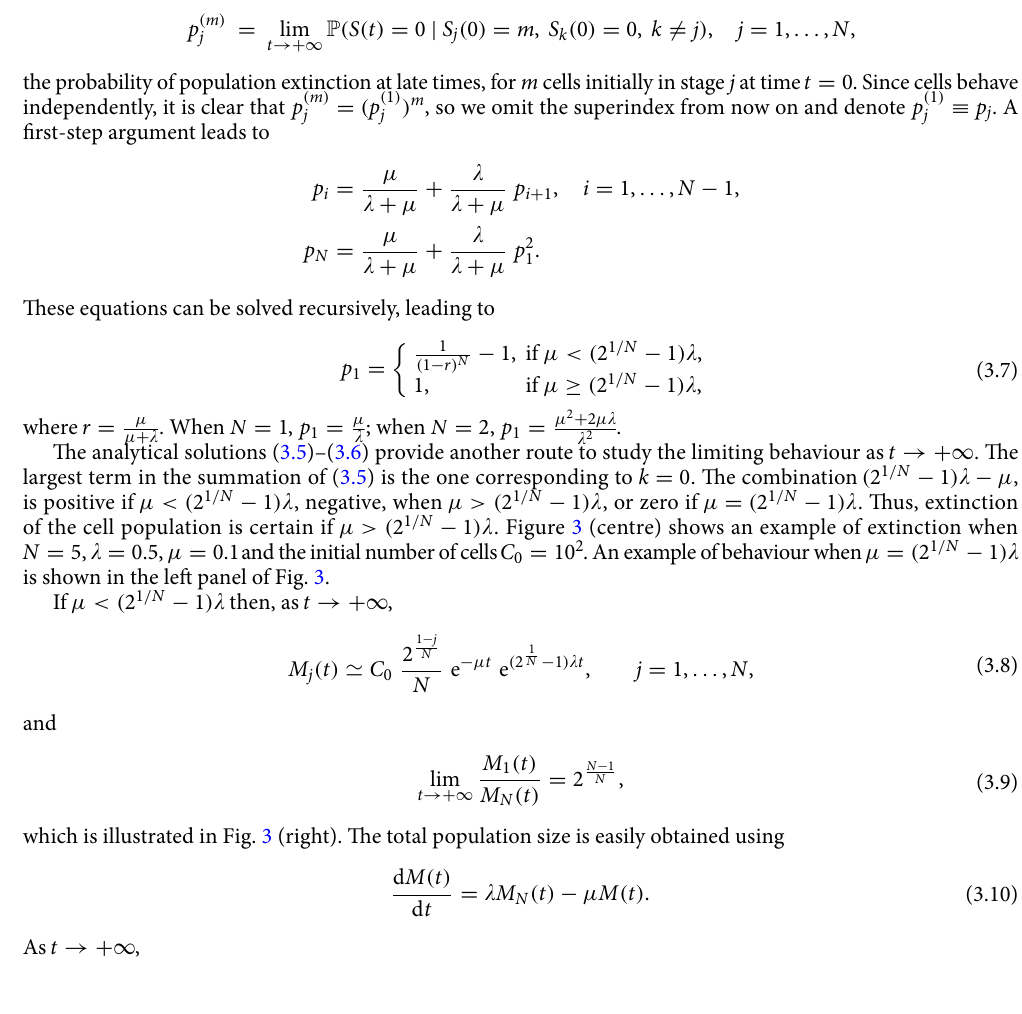
of a population with an initial number of cells, C 0 → +∞ 1 − j N C 0 / N for sufficiently large times. Centre: Parameters: N 100 , M 1 ( t ) 2 4 / 5 M 5 ( t ) = ≃